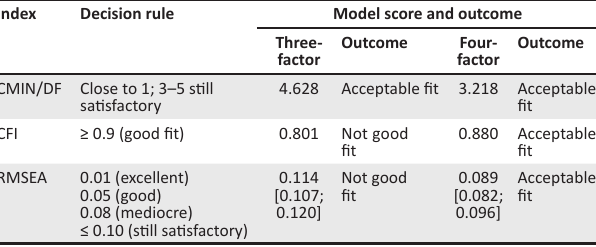
Three- Outcome Four- Outcome factor factor